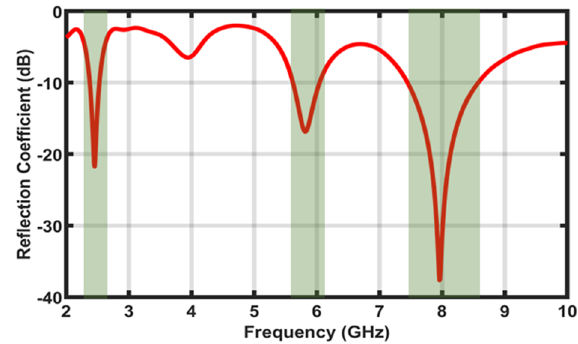
Figure 13. Simulation of antenna’s radiation paern at frequencies of 2.45 GHz, 5.8 GHz, and 8.0 GHz: ( a – c ) E-Plane and ( d – f ) H-Plane.